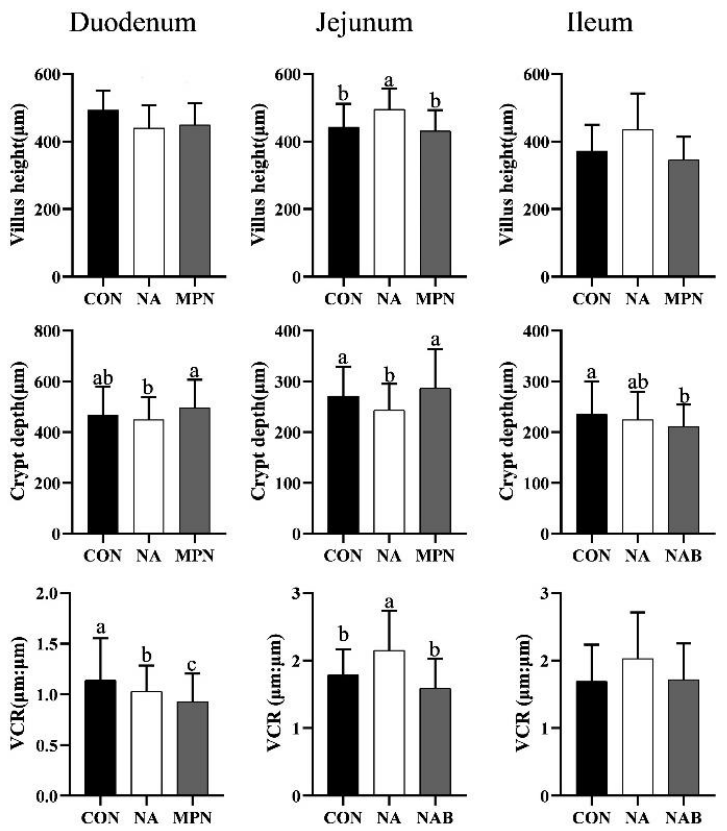
Figure 1. Effect of niacin on intestinal morphology in weaned piglets. Values are expressed as the mean ± SD, n = 8/treatment. a, b, c Values with different superscripts in the same row differ significantly ( p < 0.05). VCR, villus height-to-crypt depth ratio; CON, control group; NA, niacin group; MPN, GPR109A antagonist group.